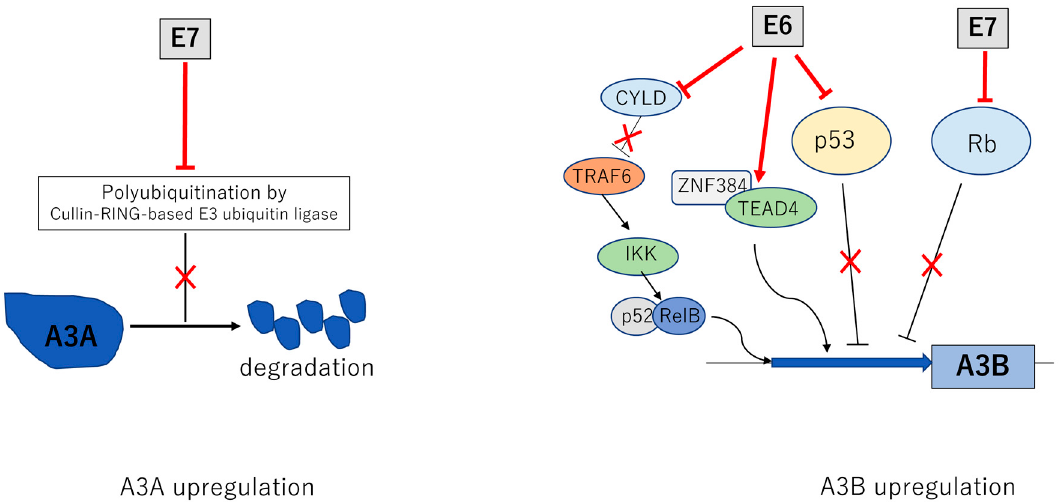
Figure 3. Activation of APOBEC3A (A3A) and APOBEC3B (A3B) by E6 and E7. Multiple mechanisms by which E6 and E7 increase levels of A3A and A3B. E6 and E7 act to increase transcription of A3B while E7 stabilizes A3A by blocking the action of a cullin E3 ubiquitin ligase. The inverted T indicates a direct inhibitory interaction with a viral protein leading to a blockage in the activity of the factor as indicated by an ×